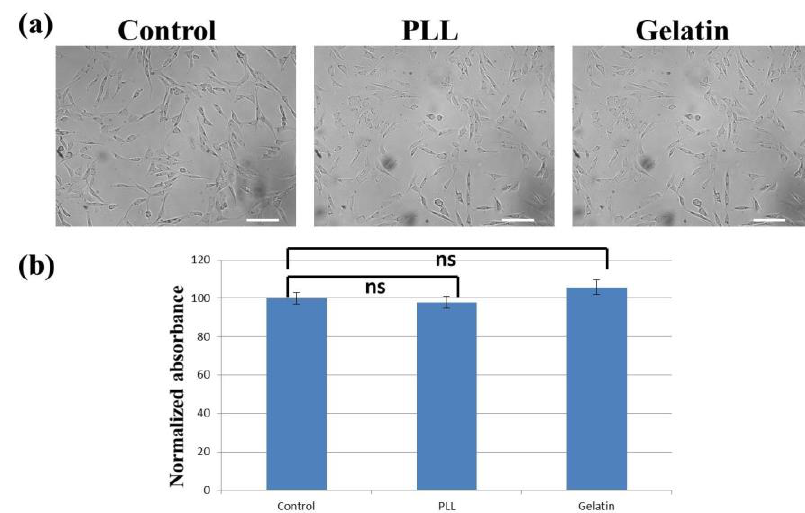
Figure 5. ( a ) Cells grown on uncoated (left), poly-L-lysine-coated (middle), and gelatin-coated (right) surfaces after 24 h. Scale bar = 100 μm. ( b ) Cell proliferation/viability on different surfaces after 24 h. Control: uncoated. PLL: Poly-L-lysine. Statistical analysis was performed on eight independent data points (see Section 2.2). Student’s t-tests were performed. ns: no statistically significant difference (p > 0.05).